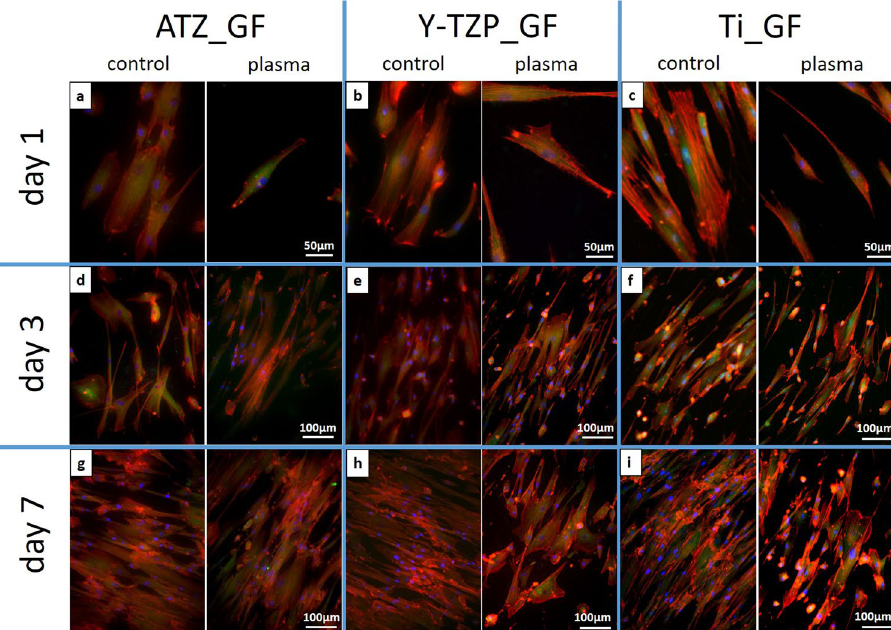
Figure 10. Indirect immunofluorescence of the phalloidin-labelled actin (red fluorescence) and the focal adhesion protein vinculin (green fluorescence) in fibroblasts cultivated for 1, 3 or 7 days on plasma- functionalized (large images) and control surfaces (inserts). Nuclei were counter-stained with Hoechst 33342 (blue fluorescence).